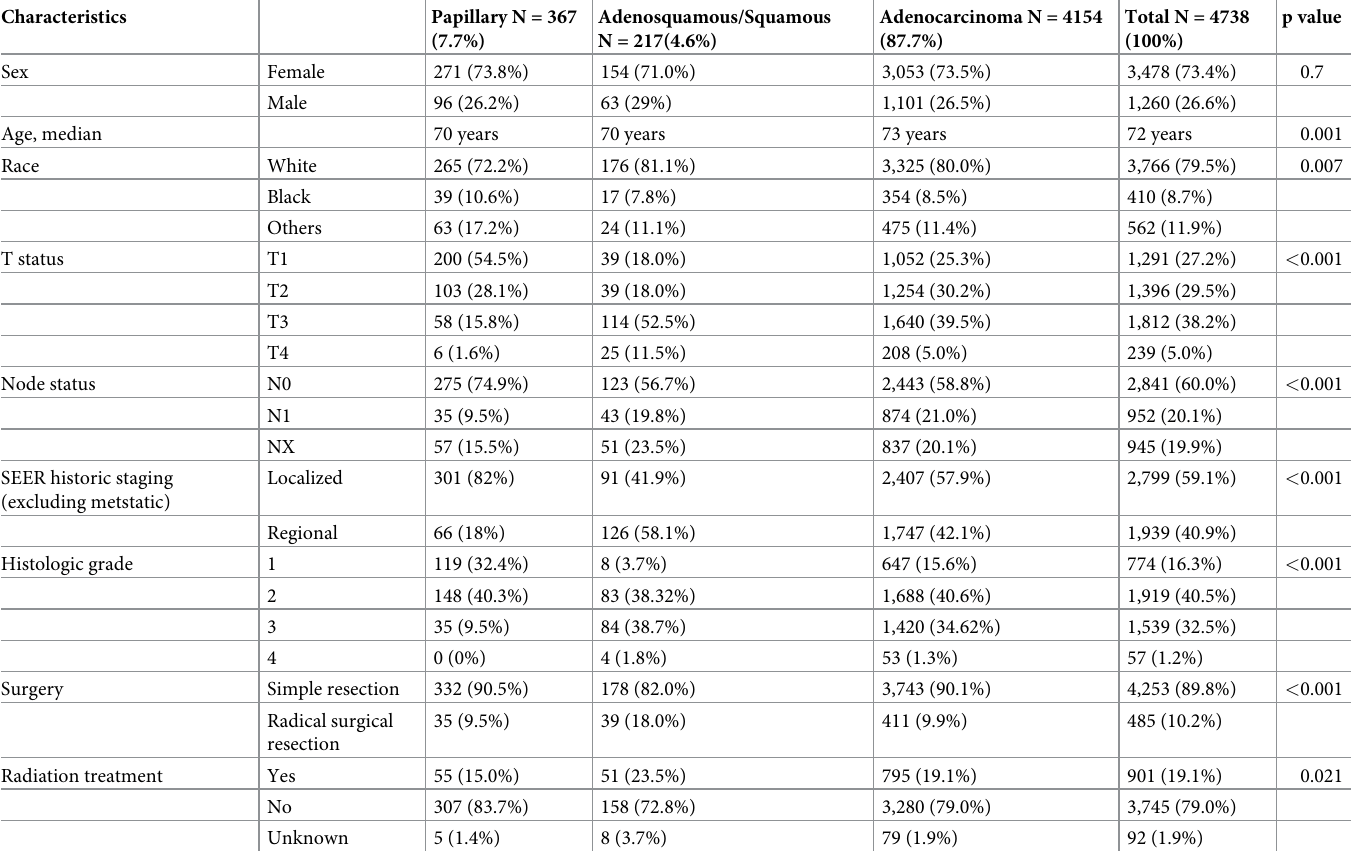
Table 1. Descriptive statistics by histology.